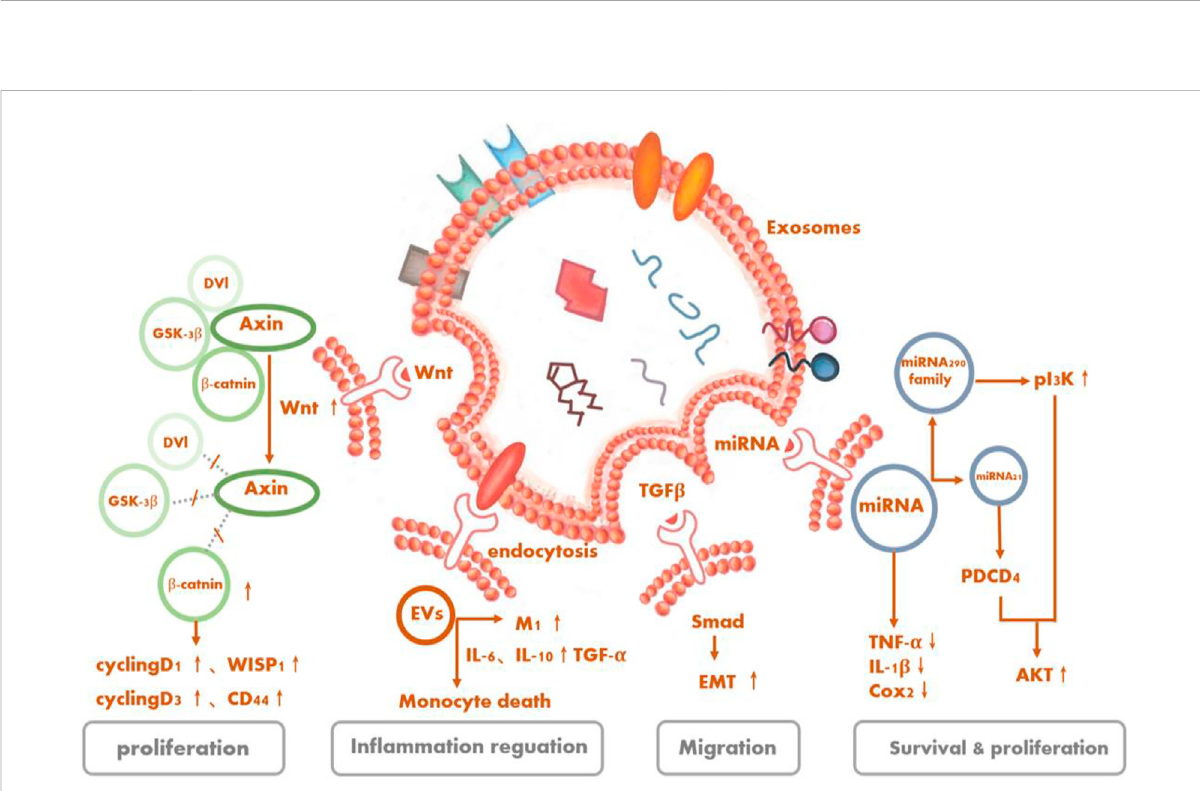
FIGURE 4 Signaling pathways as underlying potential mechanisms of stem cell-derived extracellular vesicles for retinal degeneration.